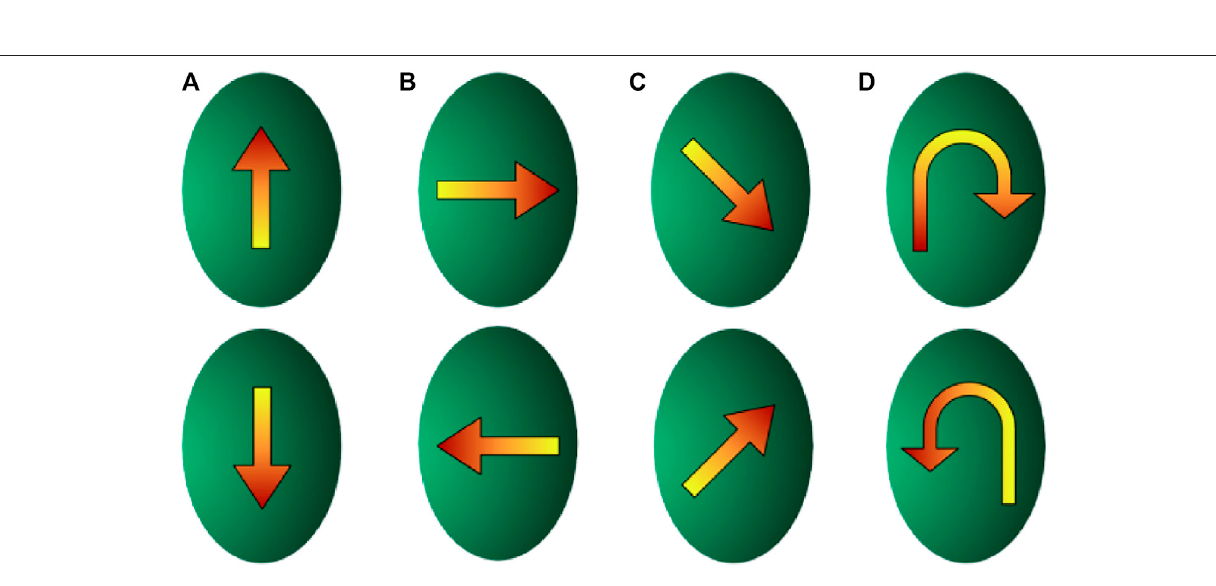
approach, shown in Figure 6 , produces smoother trajectories with reduced noise. Figure 7 quanti fi es the median error in touch tracking results for each of the waypoints, for each of the four classes of trajectories (horizontal, vertical, diagonal and circular). Our results are most accurate for the waypoints in the center of the BioTac SP as compared to those near the edges due to the shape and fl uid density of the underlying sensor. Table 1 provides a comparison of the average pixel-wise error in tracking the known waypoints ( Figure 4 ), computed with three different methods: First, we take the 24 taxel values corresponding to the timestamp at which the indenter is on each of the known waypoints 1 through 5, and train a fully connected neural network for regression on predicted locations. The average pixel-wise errors are reported under the Raw MLP heading. Similarly, we obtain the average pixel- wise errors for each of the fi ve waypoints, using the contours from raw data and from event data. These are reported under the Raw Contours and Event Contours headers respectively in